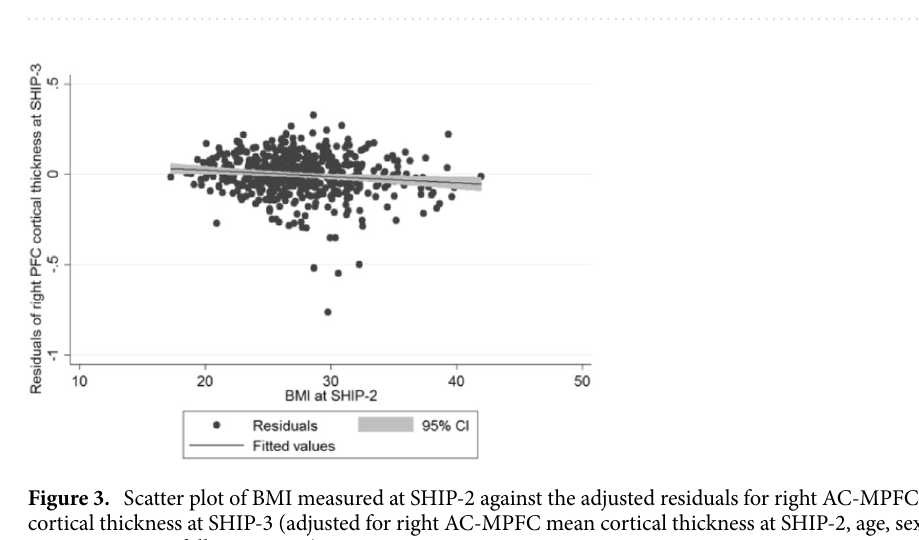
Figure 2. Scatter plot of BMI measured at SHIP-2 against the adjusted residuals for right OFC volume at SHIP-3 (adjusted for right OFC volume at SHIP-2, age, sex, age*sex interaction, ICV, follow-up time).